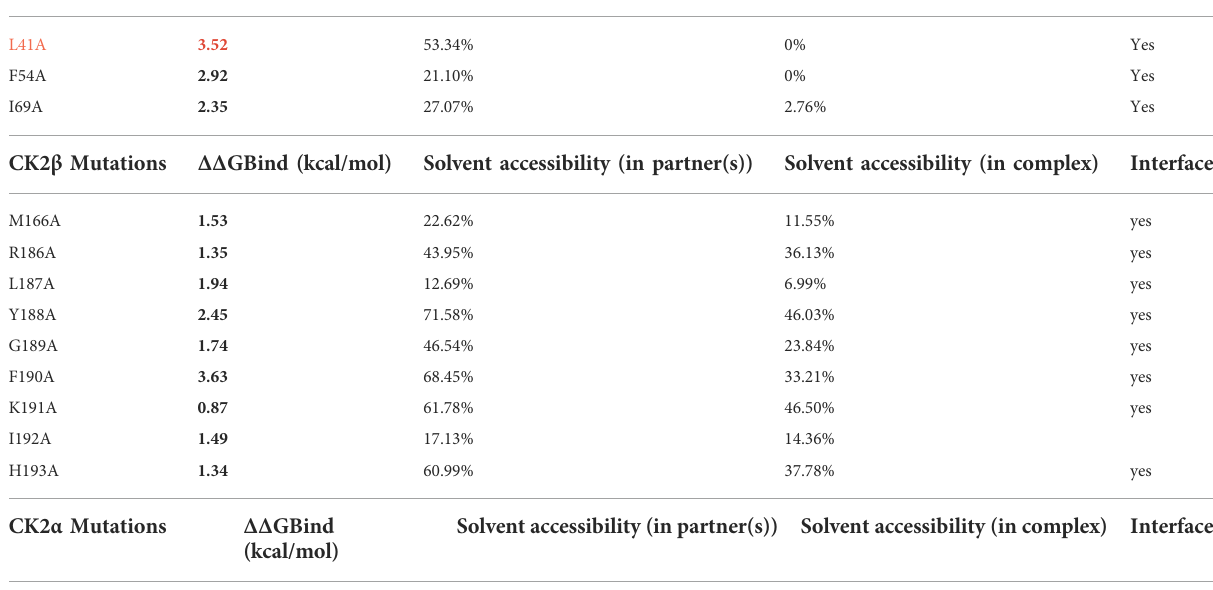
TABLE 8 Binding free energy changes between the wild type and mutant complexes. ΔΔ G values were predicted using BeAtMuSiC (Dehouck et al., 2013). For this structure based approach, the binding of one CK2 α chain (chain C) to the CK2 β dimer (chains A/B) was evaluated, using the CK2 holoenzyme structure (PDB_ID 4DGL; (Lolli et al., 2012)) as input fi le. Mutations which cause an increase of binding free energy of more than 2.0 kcal/mol upon mutation are highlighted in red in the fi rst column. Positive ΔΔ G values indicate that the mutation decreases binding af fi nity (in red),andnegative ΔΔ Gvaluesindicatethatthemutationincreasesbindingaf fi nity(ingreen).BeAtMuSiC(Dehoucketal.,2013)identi fi esaresidue as interface residue if its solvent accessibility in the complex is at least 5% lower than in the unbound form. (A) ΔΔ G values for previously experimentally characterized CK2 α variants (Raaf et al., 2011). (B) ΔΔ G values for previously experimentally characterized CK2 variants or corresponding exchanges in a CK2 β -derived cyclic peptide including CK2 β residues Arg186 to His193 (Laudet et al., 2007). (C) ΔΔ G values for OCNDS-related CK2 α variants. (D) ΔΔ G values for POBINDS-related CK2 β variants. CK2 α Mutations ΔΔ GBind (kcal/mol) Solvent accessibility (in partner(s)) Solvent accessibility (in complex)